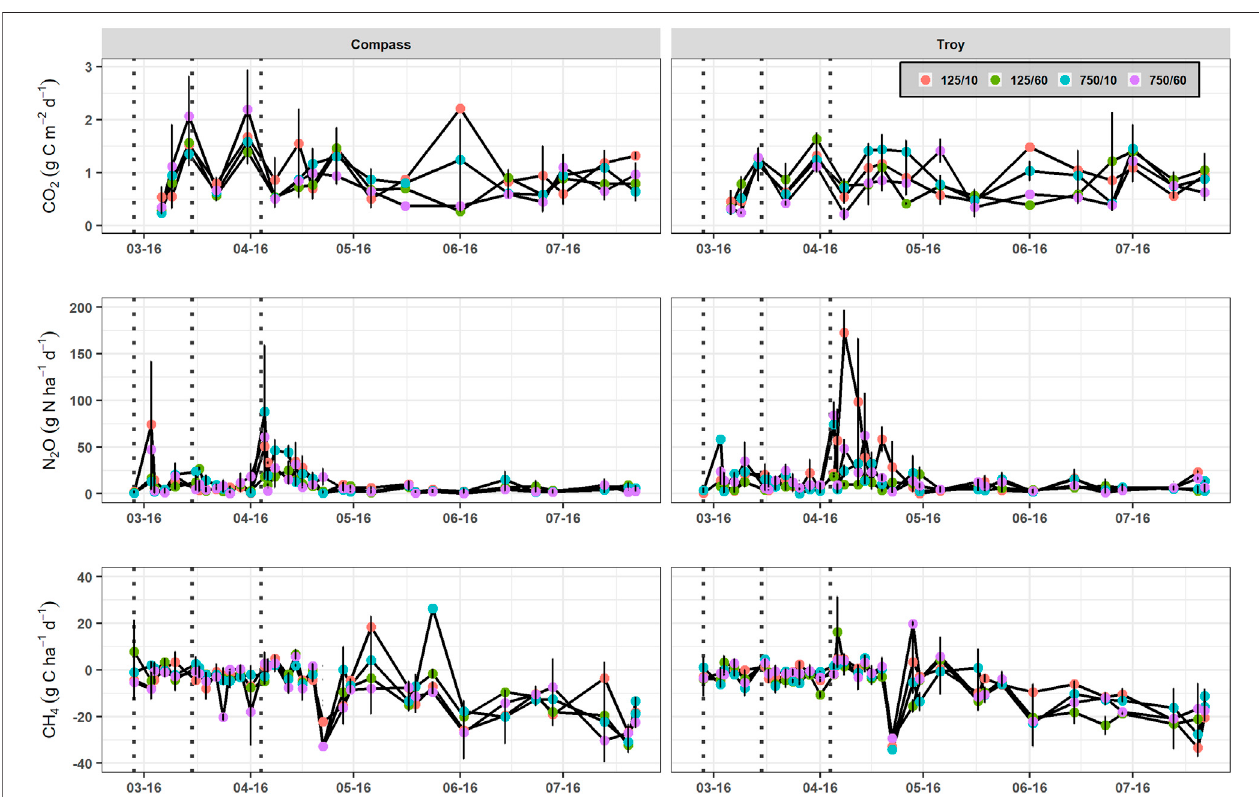
FIGURE5| SoilCO 2 ,N 2 Oand CH 4 emissions foreach sowingmethod treatment inExp.2: theconventional ( “ cv. Compass ” )and semi-dwarf( “ cv. Troy ” )biomass varieties sown at 125 mm or 750 mm row spacing with 10 or 60 seeds m − 2 . Vertical dashed lines indicate fertilizer application and the vertical lines on each data point represent standard error of the